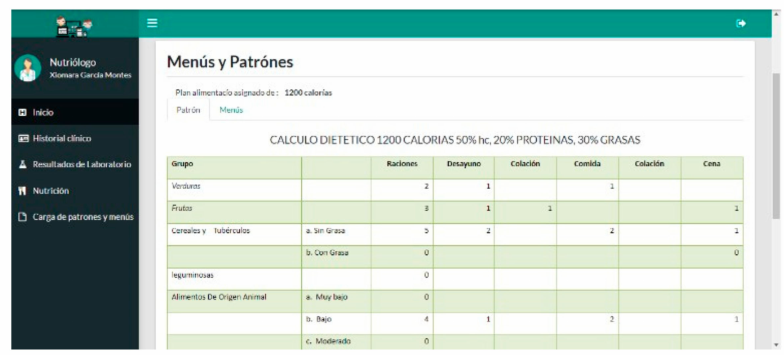
Figure 29. Nutritionist application interface: Menus and eating patterns assigned to the